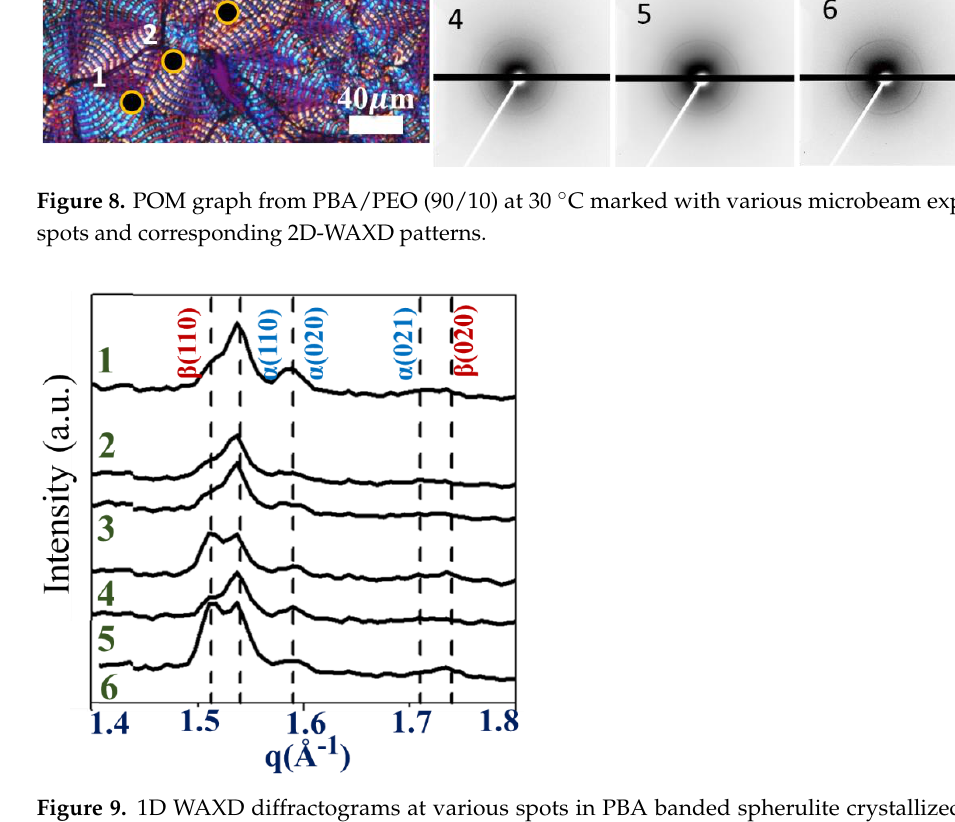
Figure 9. 1D WAXD diffractograms at various spots in PBA banded spherulite crystallized from PBA/PEO (90/10) at 30 °C. PBA/PEO (90/10) at 30 ◦